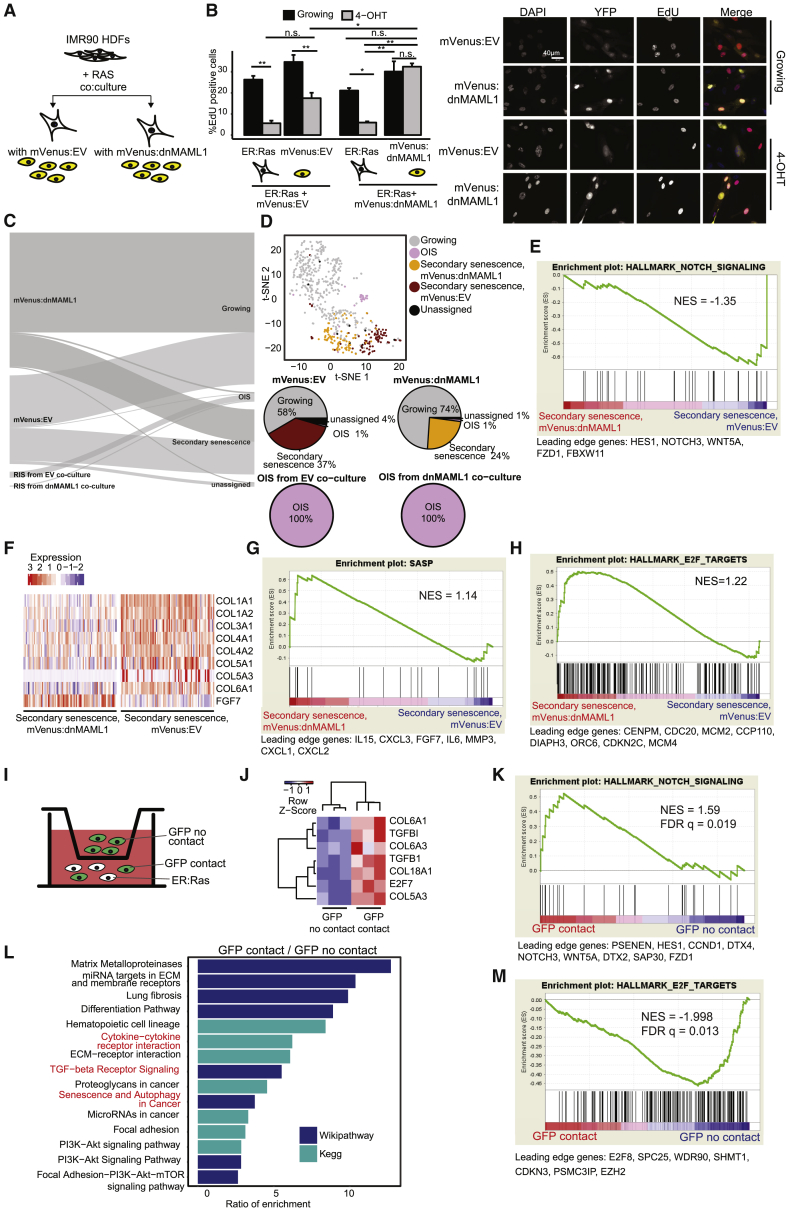
NIS Mediates Secondary Senescence In Vitro(A) Schematic representation of co-cultures with perturbed Notch signaling.(B) Bar plot for EdU incorporation in growing (black) or senescent (gray) EV or dnMAML1 cells co-cultured with ER:Ras as proportion of all cells scored. Error bars are displayed as SEM; F[7,16] = 20.63, p < 0.001, one-way ANOVA with Tukey’s test. (n = 3 per condition). Representative images are shown.(C) Scmap cluster projection of the dnMAML1 and EV 10× scRNA-seq dataset to the GFP co-culture 10× scRNA-seq dataset (see Figure 1H).(D) tSNE plot of single cells colored by the projection toward the GFP co-culture 10× dataset (see Figure 1H). Pie charts show percentage of cells.(E) GSEA pre-ranked test for enrichment of Notch signaling in mVenus:EV identified as secondary senescence by scmap.(F) Heatmap of single-cell data comparing mVenus:EV and mVenus:dnMAML1 for collagens and SASP genes. Red, upregulated and blue, downregulated.(G) GSEA pre-ranked test for enrichment of SASP genes in mVenus:dnMAML1 identified as secondary senescence by scmap.(H) GSEA pre-ranked test for enrichment of E2F targets in mVenus:dnMAML1 identified as secondary senescence by scmap.(I) Schematic representation of transwell co-culture assay of OIS and GFP cells.(J) Heatmap of significantly differentially expressed genes (p < 0.05) between GFP contact and GFP no contact cells.(K) GSEA pre-ranked analysis for enrichment of Notch signaling in GFP contact cells compared to GFP no contact cells.(L) Pathway analysis for DE genes between GFP contact/GFP no contact (p < 0.05).(M) GSEA pre-ranked analysis for enrichment of E2F targets in GFP no contact compared to GFP contact cells. Leading edge genes are indicated.Related to Figure S3 and Table S2.